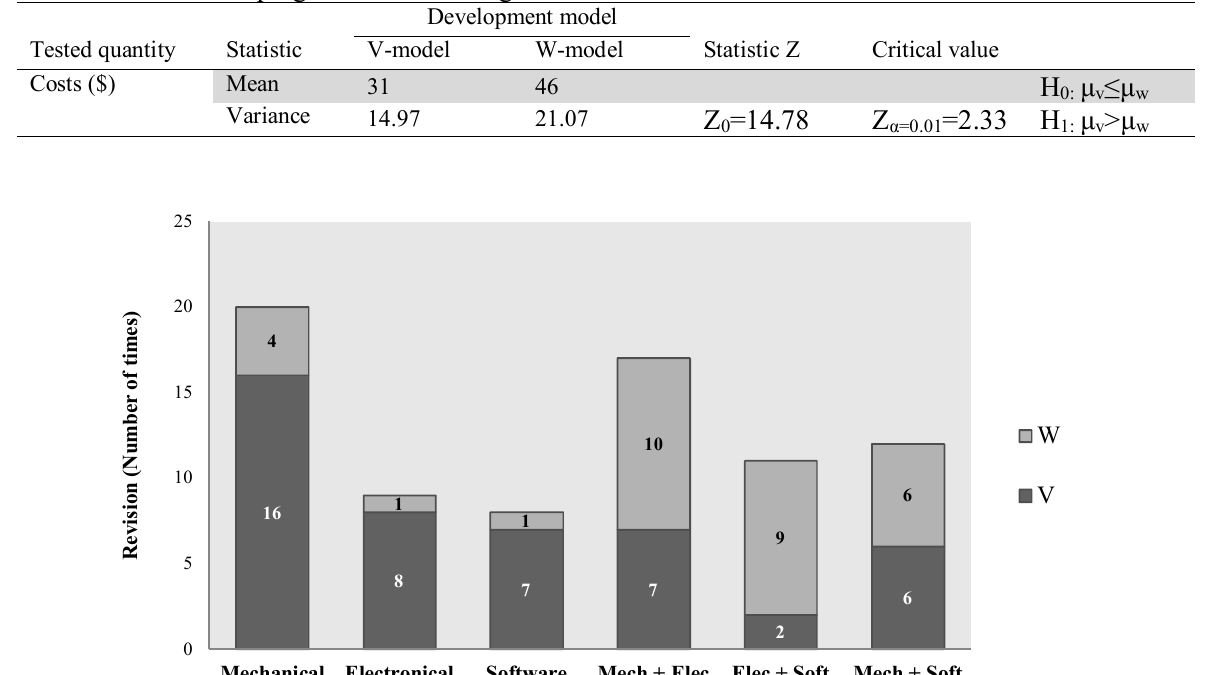
Results from developing tracer robot using V-model and W-model